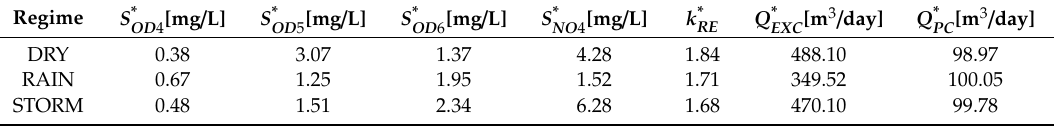
Table 4. Optimal setpoints for each operating regime of the wastewater treatment plant. Regime